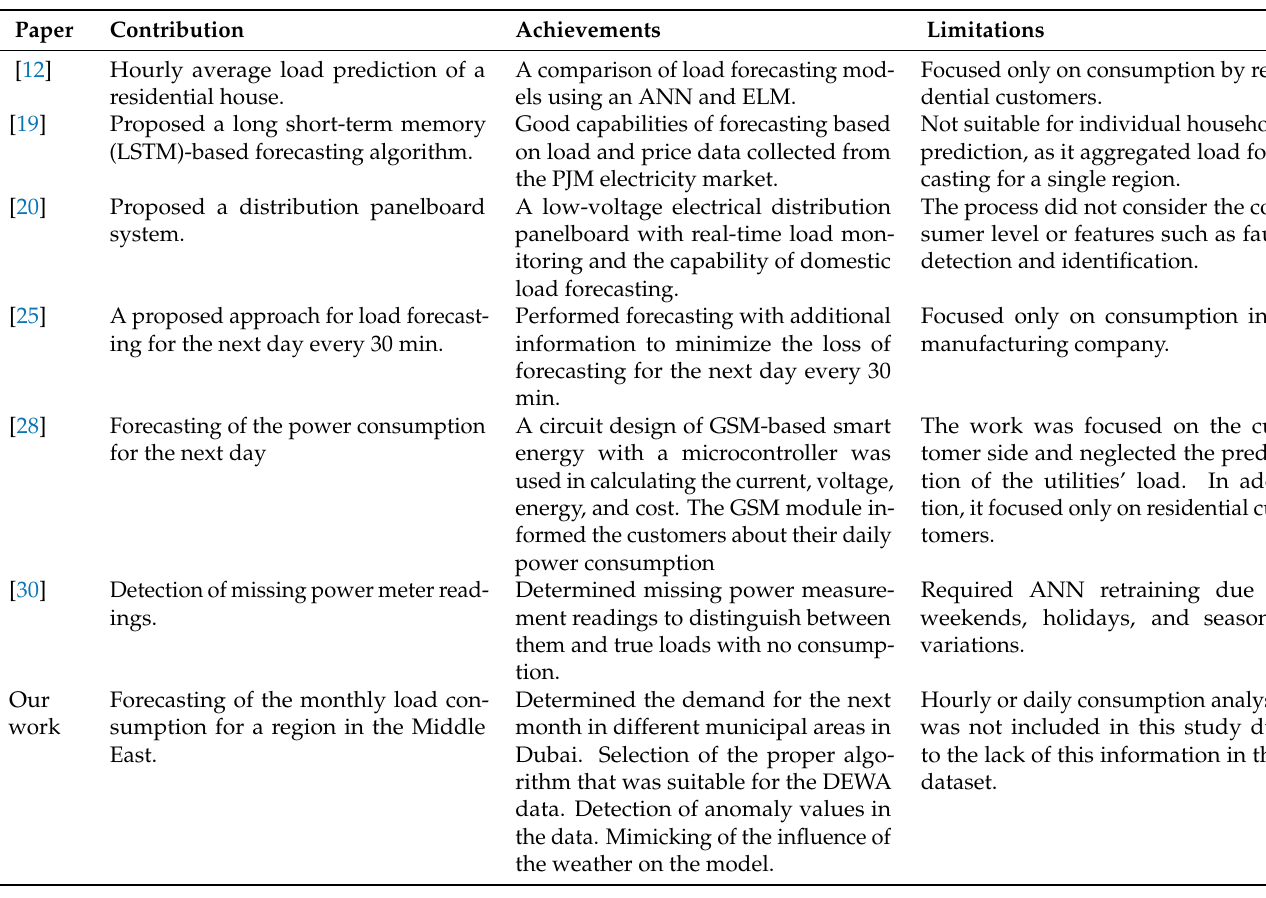
Table 1. A comparison between the related work and the proposed